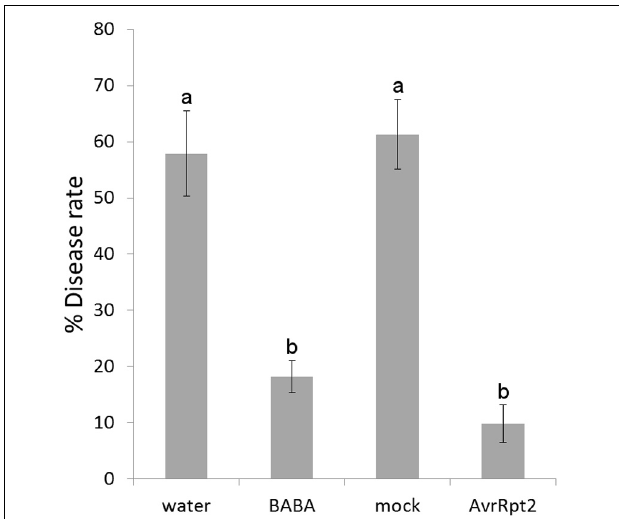
FIGURE 1 | Disease symptoms in Col-0 plants. Arabidopsis plants were inoculated with a bacterial suspension of Pst at 10 5 colony-forming units (cfu). mL − 1 . Disease symptoms were determined after 5 days of inoculation and quantified as the proportion of leaves with symptoms. The values are means of the percentage of diseased leaves per plant ± SD. Data presented are from a representative experiment that was repeated for every experiment with similar results. Different letters indicate statistically significant differences between control and infected plants ( p < 0 . 05, n =